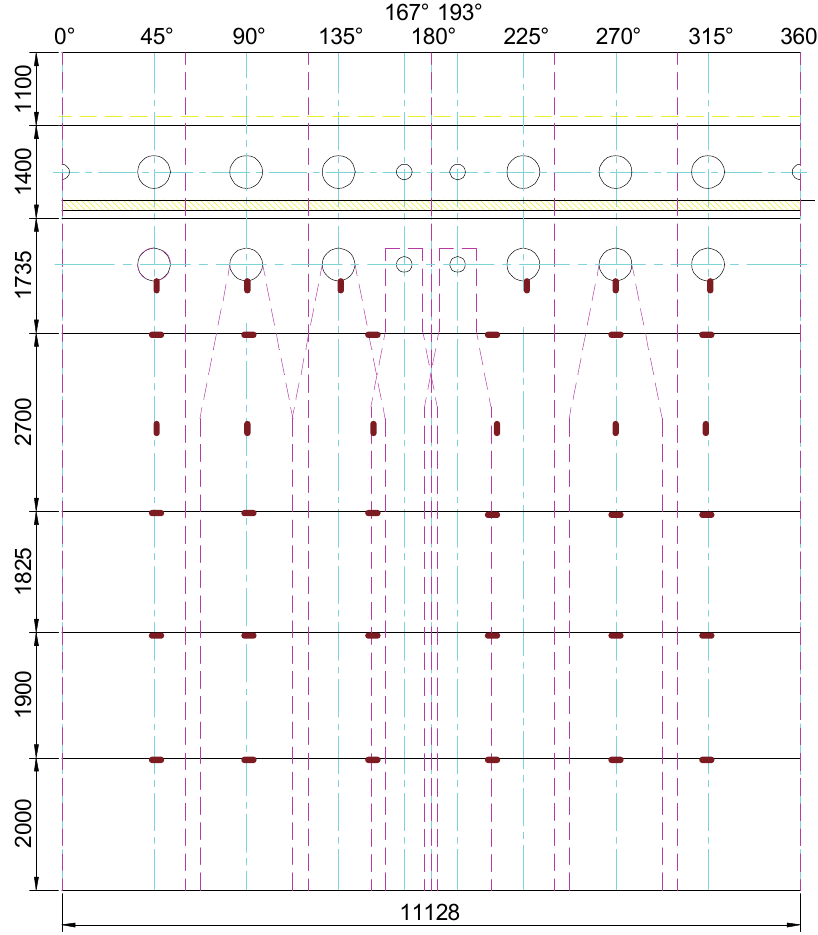
Figure 3: Locations selected for fracture mechanics calculations on a VVER-440 RPV.